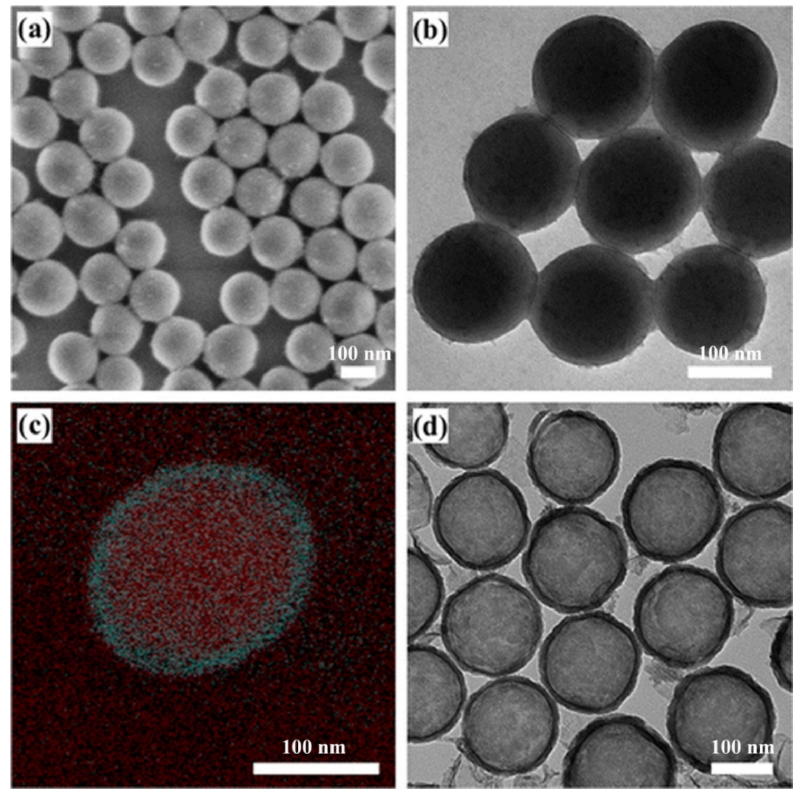
Figure 11. FE–SEM ( a ), TEM ( b ), and EDX–STEM mapping micrographs ( c ) of PS@SiO 2 core–shell particles prepared by emulsifying a mixture of St (1.2 g) and PEOS (1.2 g) in the water of pH 7 via ultrasonication and subsequent heating at 70 ◦ C. ( d ) TEM image of SiO 2 hollow particles obtained by calcination of the core–shell particles. Blue color indicates the presence of silicon atoms, and red color corresponds to carbon atoms. Reproduced from [83] with permission from the American Chemical